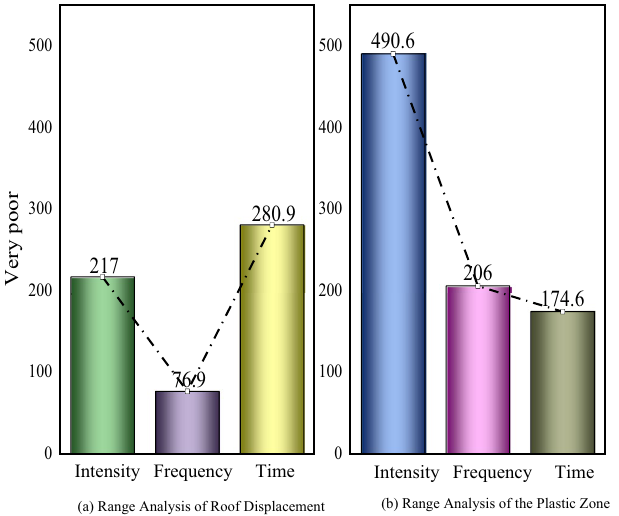
Figure 19. Factor sensitivity to deformation and failure of surrounding rock Supplementary